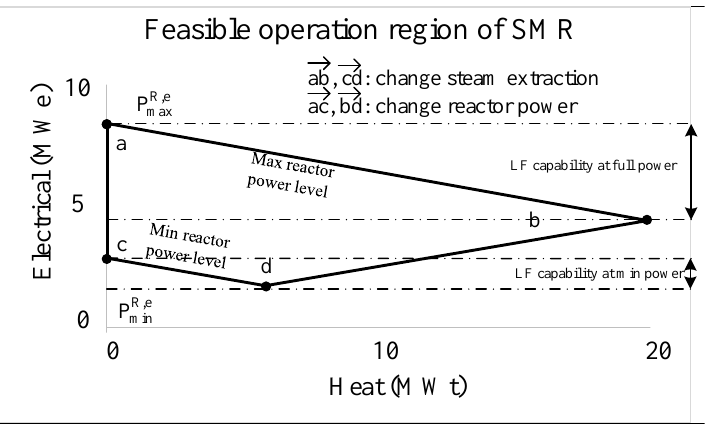
Figure 4. SMR’s feasible operation